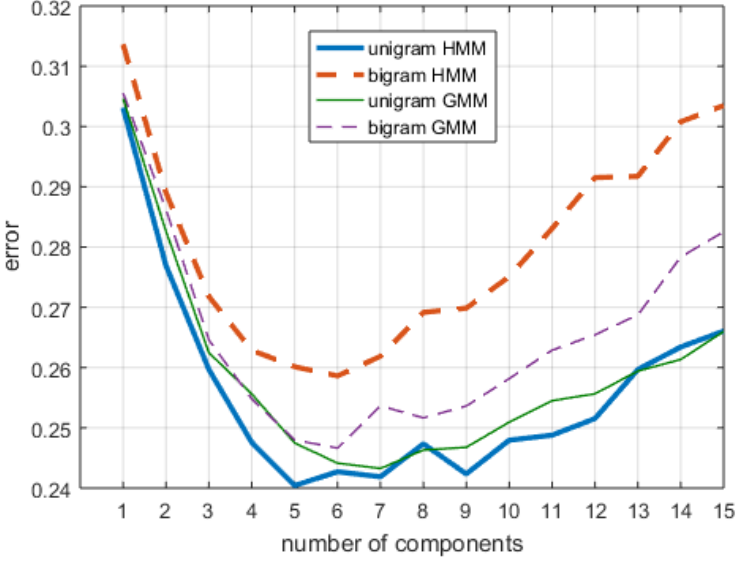
Figure 5. Classification error as a function of the number of mixture components, n-gram differences and classifier type. Standard deviations had a mean of 8.43% and a range of 3.38% across all